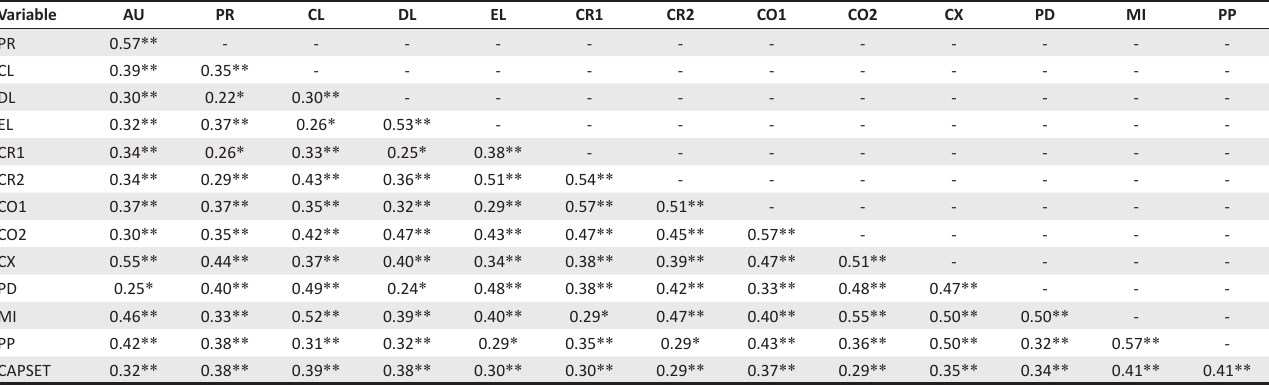
TABLE 5: 21CC capabilities phi coefficients and point-biserial correlations. Variable AU